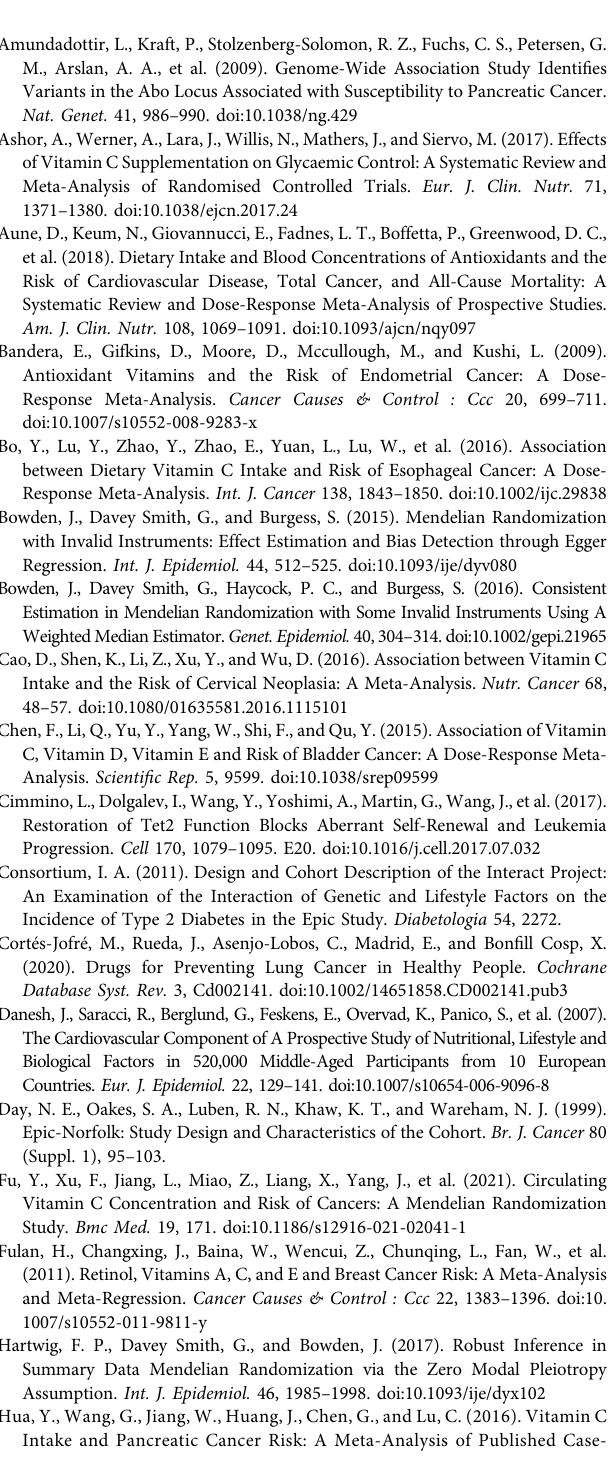
Supplementary Figure S11 | Scatter plot of vitamin C on endometrial cancer. (A) Scatter plot of vitamin C on endometrial cancer in UK Biobank. (B) Scatter plot of vitamin C on endometrial cancer in FinnGen